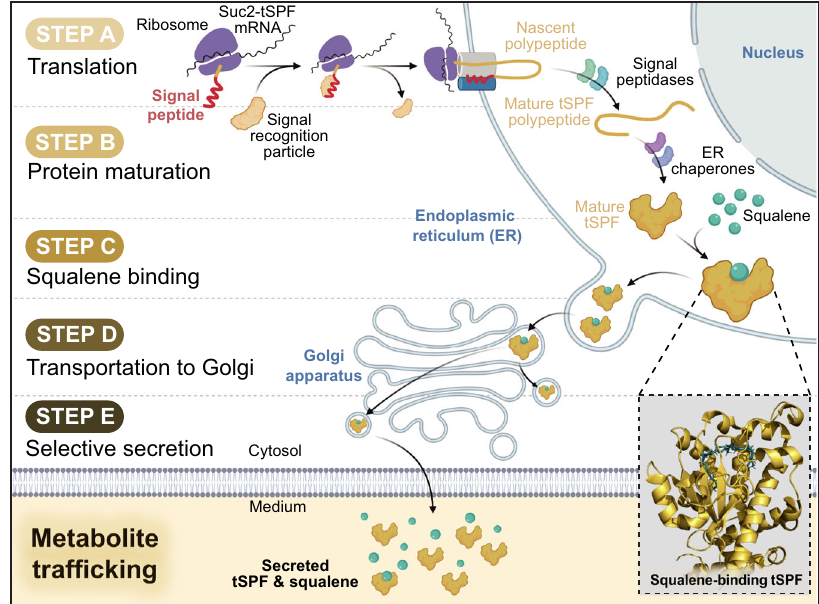
Fig. 1 Metabolite traf fi cking pathway for selective terpene secretion. By combining a squalene-binding protein, a lipid-binding domain of supernatant protein factor (tSPF), and the export signal peptide of sucrose transport protein (Suc2), we systematically designed a fusion protein, Suc2-tSPF. Lipophilic squalene could be loaded into the Suc2-tSPF and transported into the extracellular milieu, across the otherwise impermeable membrane. To achieve selective terpene secretion, Suc2-tSPF performs a series of coordinated actions. During Suc2-tSPF mRNA translation, the N-terminal signal peptide is bound to a signal recognition particle for co-translational translocation, and the complex of the ribosome with the partially translated Suc2-tSPF is transferred to the endoplasmic reticulum (ER) membrane ( step a ). A nascent polypeptide is synthesized, and the signal peptide is cleaved by signal peptidases in the ER lumen, leaving behind a tSPF polypeptide ( step b ). The tSPF polypeptide is further modi fi ed by ER chaperones to form a mature tSPF protein, which captures squalene, the target metabolite ( step c ). Once squalene succeeds in hitchhiking, the tSPF protein, encapsulated by a transport vesicle, is subsequently transported to a Golgi apparatus ( step d ). To fi nalize squalene traf fi cking, a secretory vesicle exports the squalene-carrying tSPF into the extracellular space ( step e